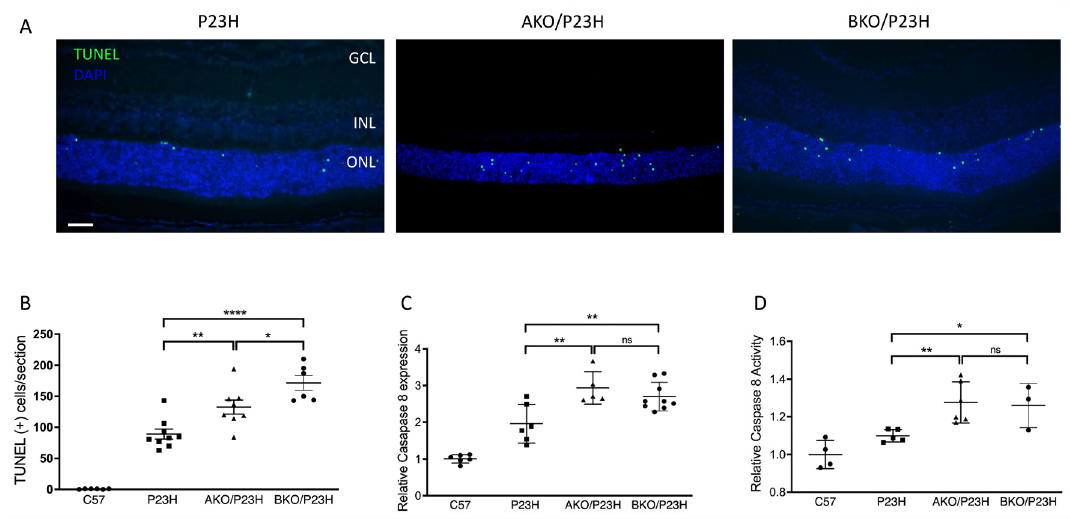
Figure 3. Increase in activation of apoptosis in the photoreceptors of AKO/P23H and BKO/P23H mice. ( A ) Representative TUNEL (green) staining images for AKO/P23H, BKO/P23H, and P23H mice at P14. Nuclei were counterstained with DAPI (blue). ( B ) Quantification of TUNEL-positive cells in the ONL of AKO/P23H, BKO/P23H, and P23H mice. Three non-continuous sections crossing the optic nerve head were used for the quantification of each eye. ( C ) Quantification of transcript levels of caspase 8 in the retinas of AKO/P23H, BKO/P23H, and P23H mice at two months of age, normalized to C57 mice. ( D ) Quantification for caspase 8 activity in the retina of AKO/P23H, BKO/P23H, and P23H mice at two months of age, normalized to C57 mice. (n ≥ 6), * p < 0.05; ** p < 0.01; **** p < 0.0001; ns, not significant. One-way ANOVA. Scale bar: 50 µm. GCL: ganglion cell layer, INL: inner nuclear layer, ONL: outer nuclear layer.